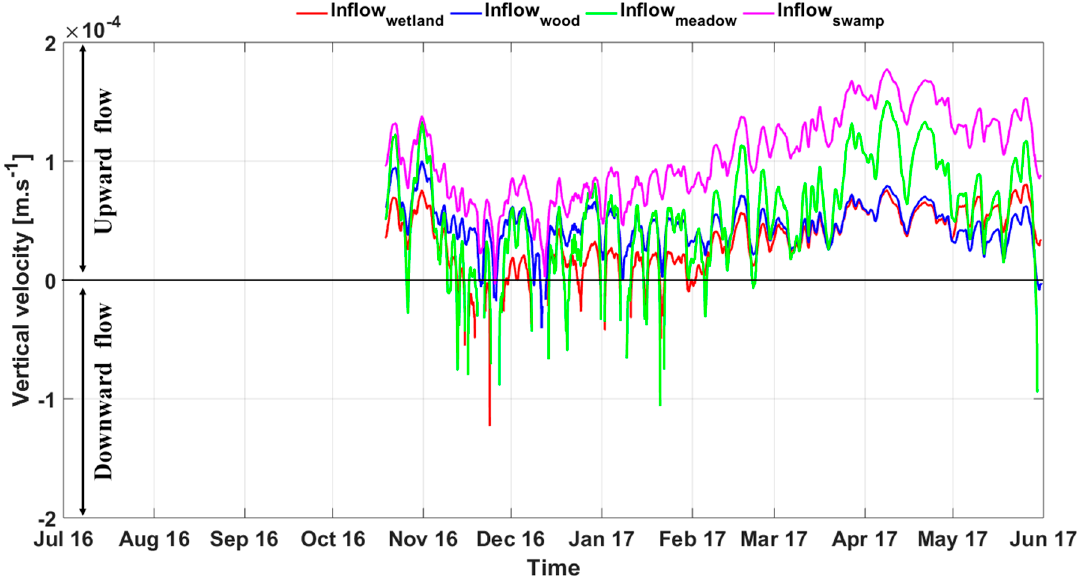
Figure 7. Vertical flow velocities calculated from temperatures at z = 0 cm and fiber optic distributed temperature sensing (z = − 3 cm) for the wetland, woods, meadow, and swamp sub-reaches. Error bars are based on 500 Monte Carlo iterations with variable thermal parameters of the sediments.